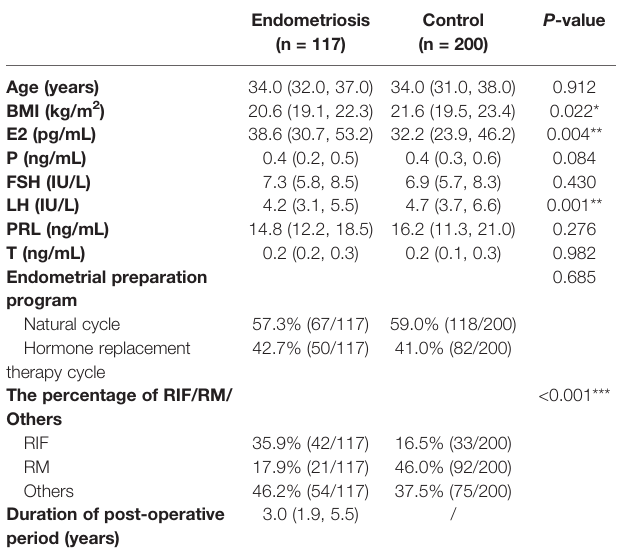
TABLE 1 | Baseline characteristics of the study population.